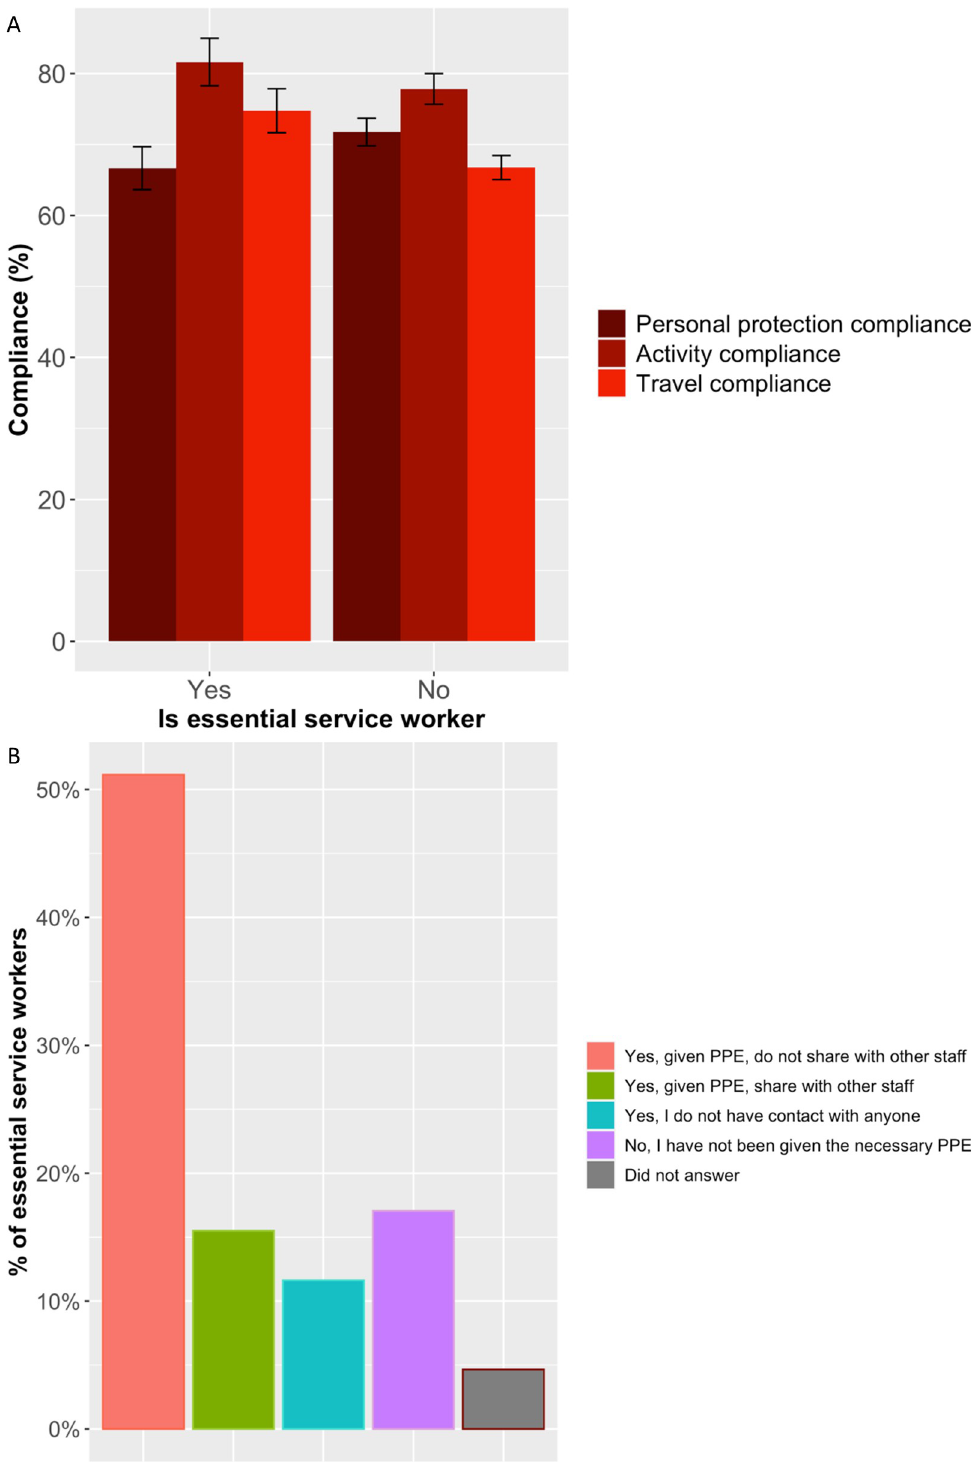
Fig 2. A. Mean compliance for each compliance component by essential worker. B. Personal Protective Equipment (PPE) for essential workers, Yes = essential workers. No = not essential workers.